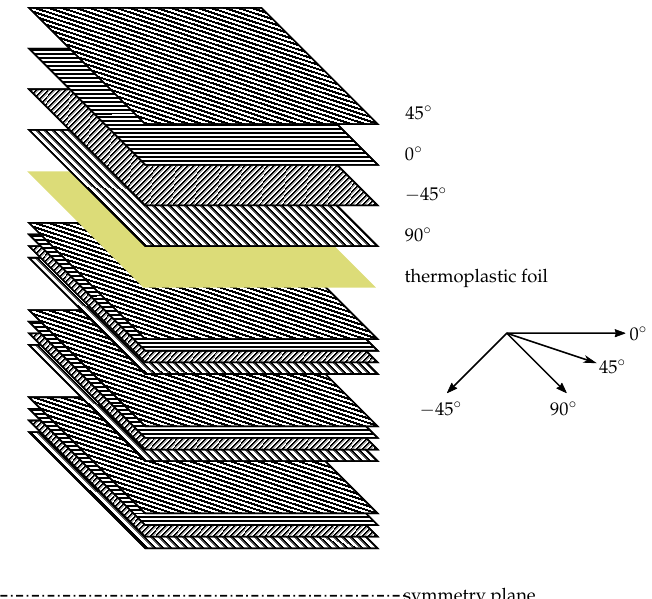
Figure 6. Layup of Compression After Impact (CAI) coupon with integrated thermoplastic film.